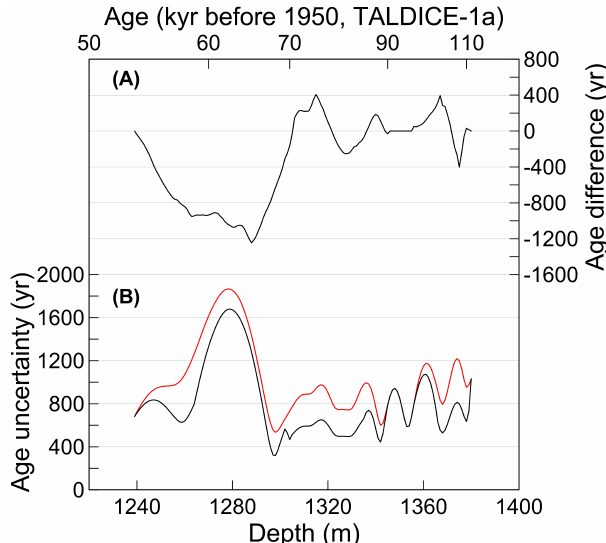
Fig. 4. (A) The ice age differences of the refined TALDICE-1a age scale compared to TALDICE-1 (the age difference is defined as TALDICE-1a age subtracted by the TALDICE-1 age at the re- spective depth). (B) Age uncertainties of the original TALDICE-1 ice age scale (red line), (Buiron et al., 2011) and the reduced un- certainties of the refined TALDICE-1a ice age scale (black line), respectively. The corresponding age (TALDICE-1a) is indicated on